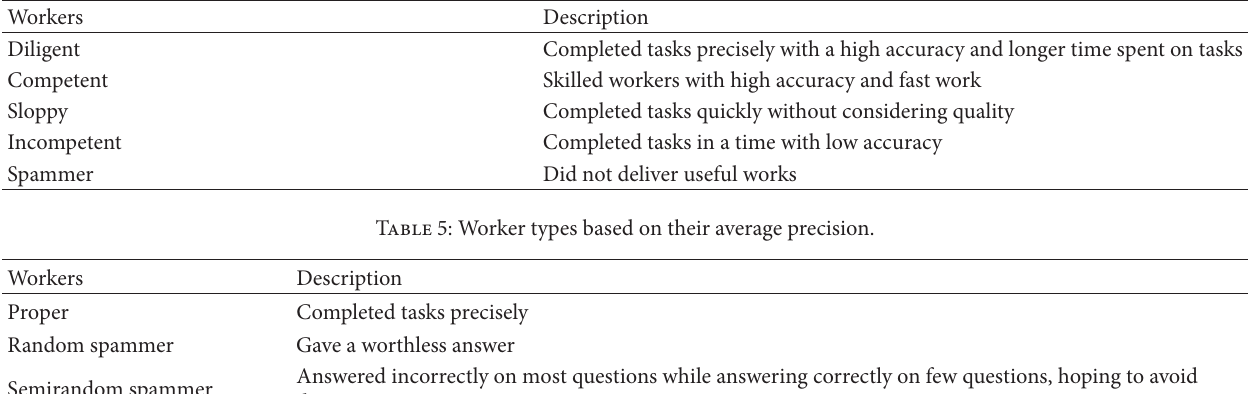
Table 4: Worker types based on their behavioral observation.